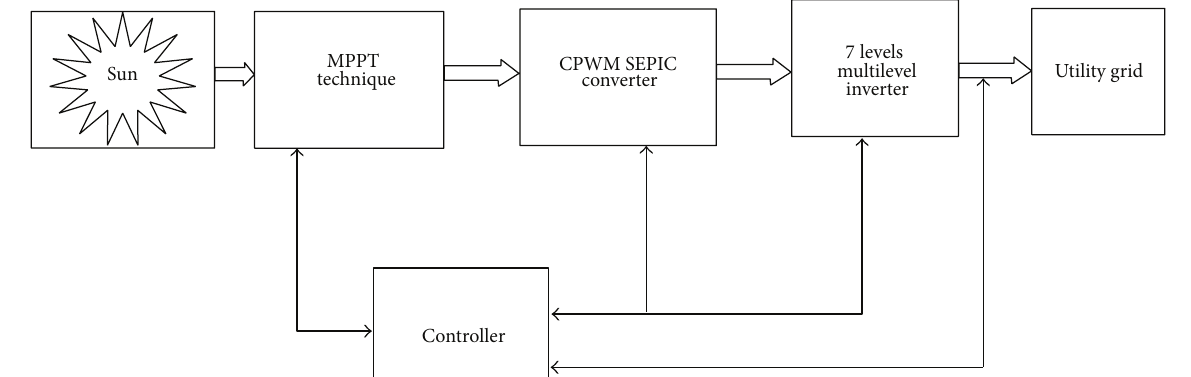
Figure 15: Block diagram of reliable high efficient grid-connected solar power system.